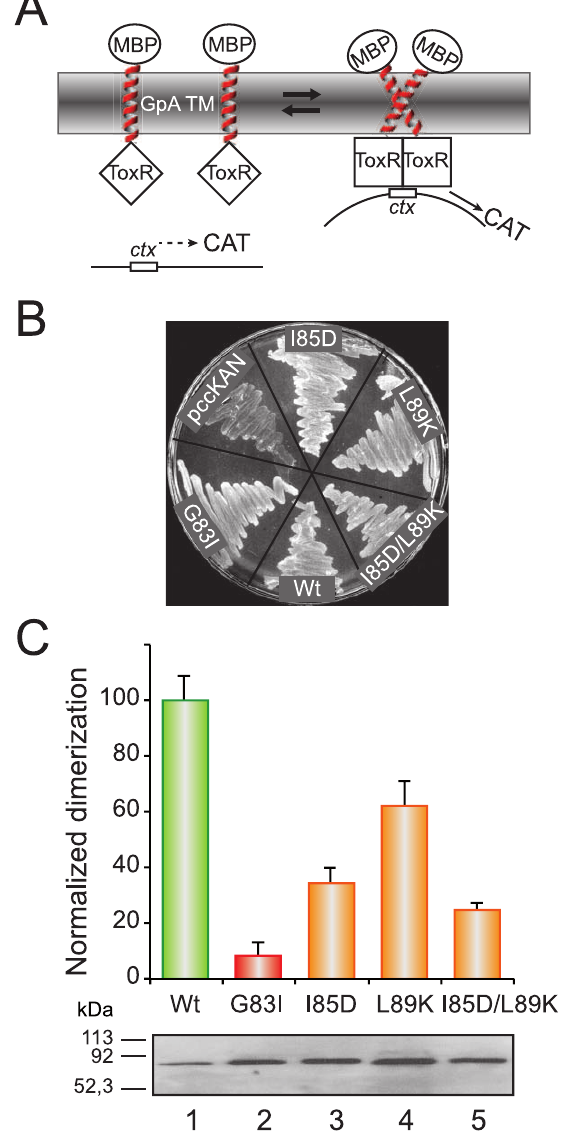
Figure 5. Dimerization in E. coli membranes. (A) Schematic representation of the ToxCAT assay. ToxR domains (squares) can activate transcription of the reporter gene (CAT) if brought together by the GpA-derived TM domains (right). The maltose binding protein domain (ellipses) helps direct the insertion of the construct into the membrane, complements the malE mutation in the host cells, and serves as an epitope for quantifying the expression level of fusion protein. (B) Complementation assays for wild-type and selected mutant ToxR(GpA)MBP fusion constructs. NT326 cells ( malE deficient) carrying various constructs were streaked on a plate with maltose as the sole carbon source and grown for three days at 37 u C. All ToxR(GpA)MBP chimeras permit growth of NT326 cells on maltose, while control transformants (pccKAN) do not. (C) Normalized dimerization of the indicated TM domain variants as measured by CAT-ELISA relative to the wild-type GpA TM domain. Bars for intermediate dimerization and non- dimerizing levels are colored orange and red, respectively. Average 6 s.d. of results from four independent experiments are shown. Levels of expression of selected ToxR(GpA)MBP constructs as analyzed by immunoblotting are shown at the bottom.